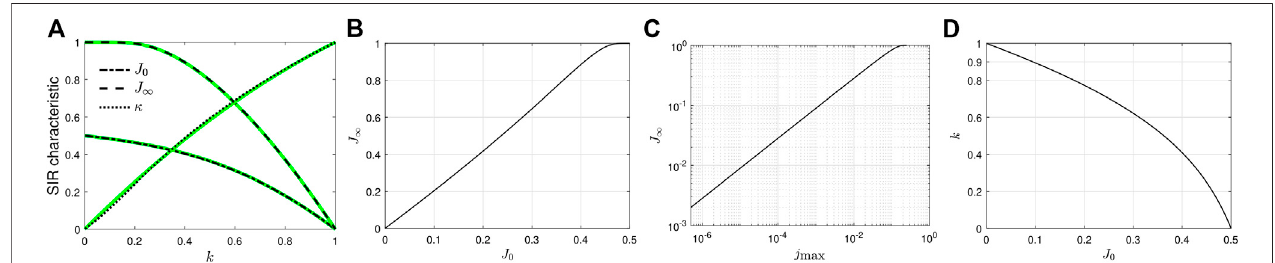
FIGURE 1 |(A) Approximants J 0 , J ∞ , and κ (thick green)used in this manuscript, cf. Eqs (5) – (7) , compared with the exact functions [19] (thin black). (B) J ∞ vs. J 0 and (C) J ∞ vs. j max for the SIR model. (D) k as function of J 0 according to Eq. 14 . For J 0 ≤ 0 . 1 this is well approximated by k ≈ 1 − J 0 , where J 0 can be replaced by the cumulative fraction of infected people at the time of the maximum in the daily number of newly infected people.